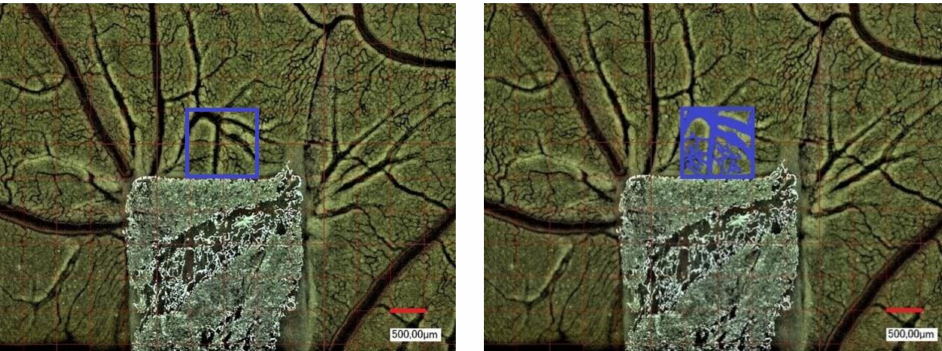
Figure 2. Example of microscopic analysis of vessel and branching points. After centering the matrix, the same region of interest (ROI) of 500 × 500 µ m was standardly applied for every experiment. The number of vessels and the branching points (highlighted in blue) per mm 2 of the ROI were counted manually. Magnification: